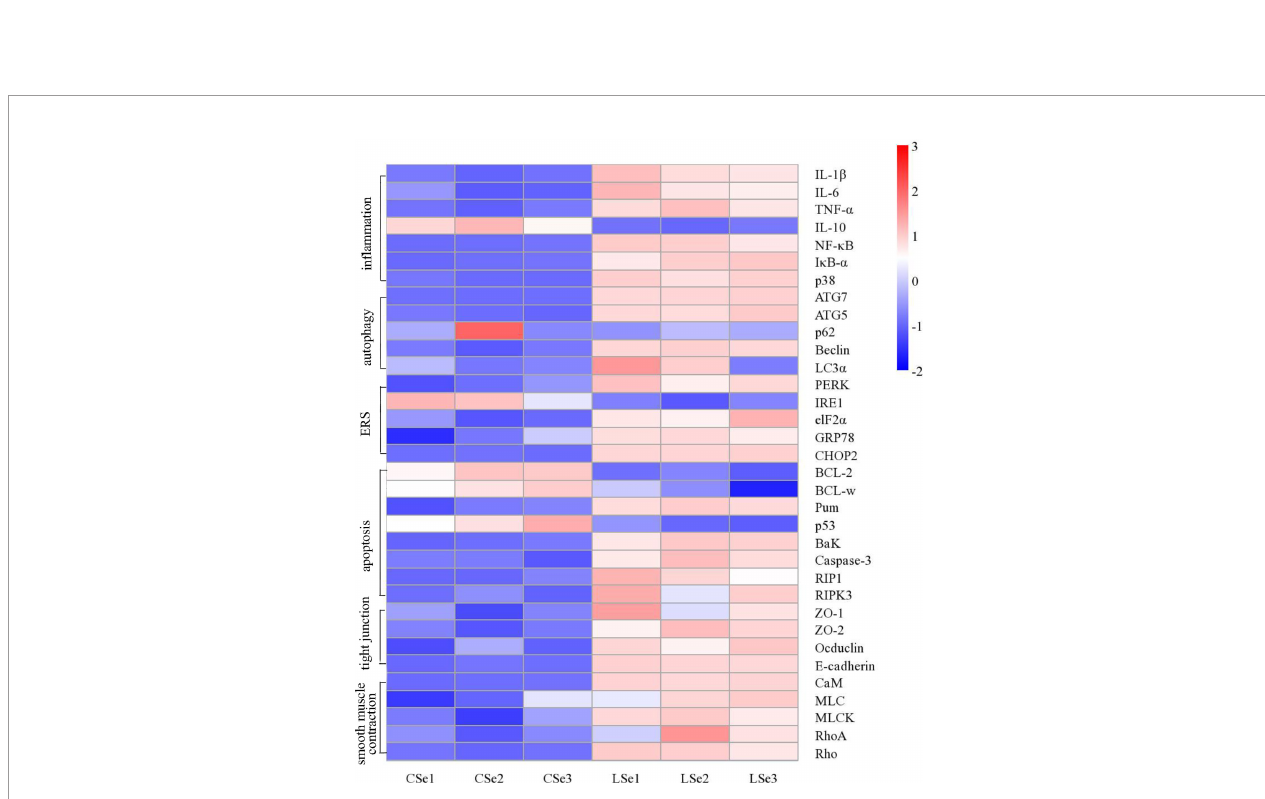
FIGURE 10 | Analysis of mRNA expression level in small intestine tissue. The Ct values measured by PCR were calculated by 2- △△ Ct and then standardized. The abscissa is the sample name and the ordinate is the gene name. p <